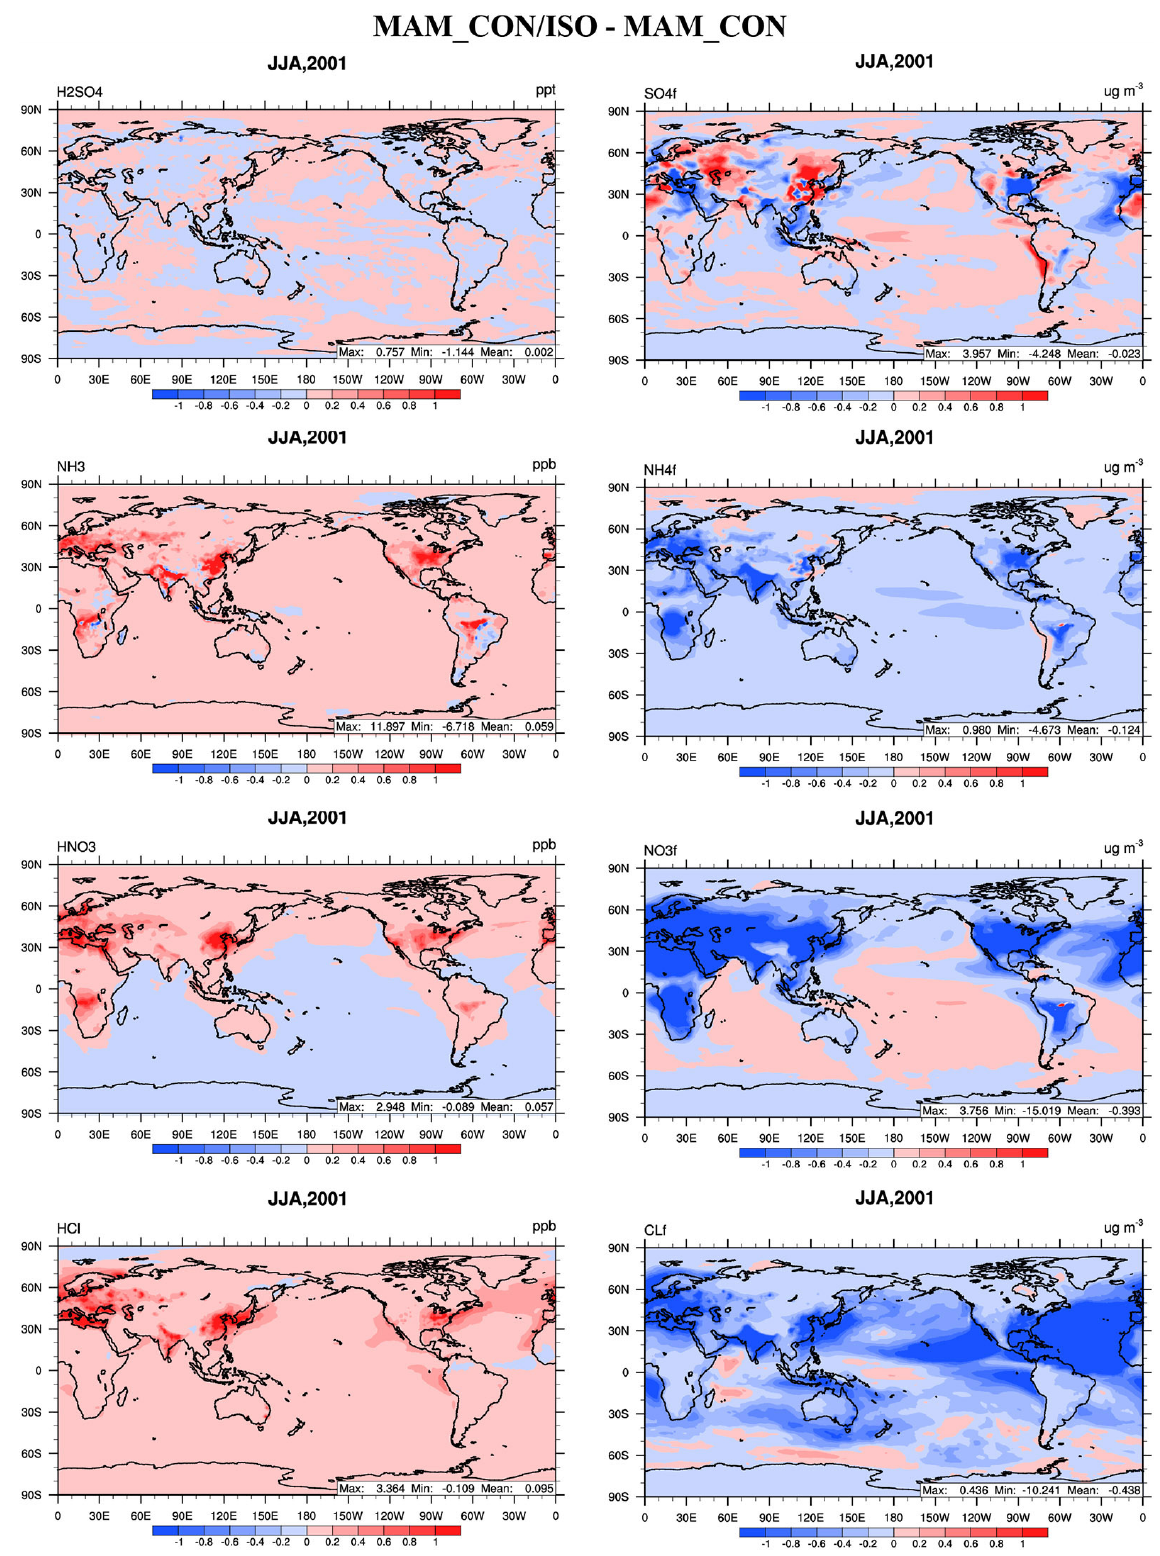
Figure 6. Absolute differences of major PM species and their gas precursors between MAM_CON/ISO and MAM_CON for summer, 2001.